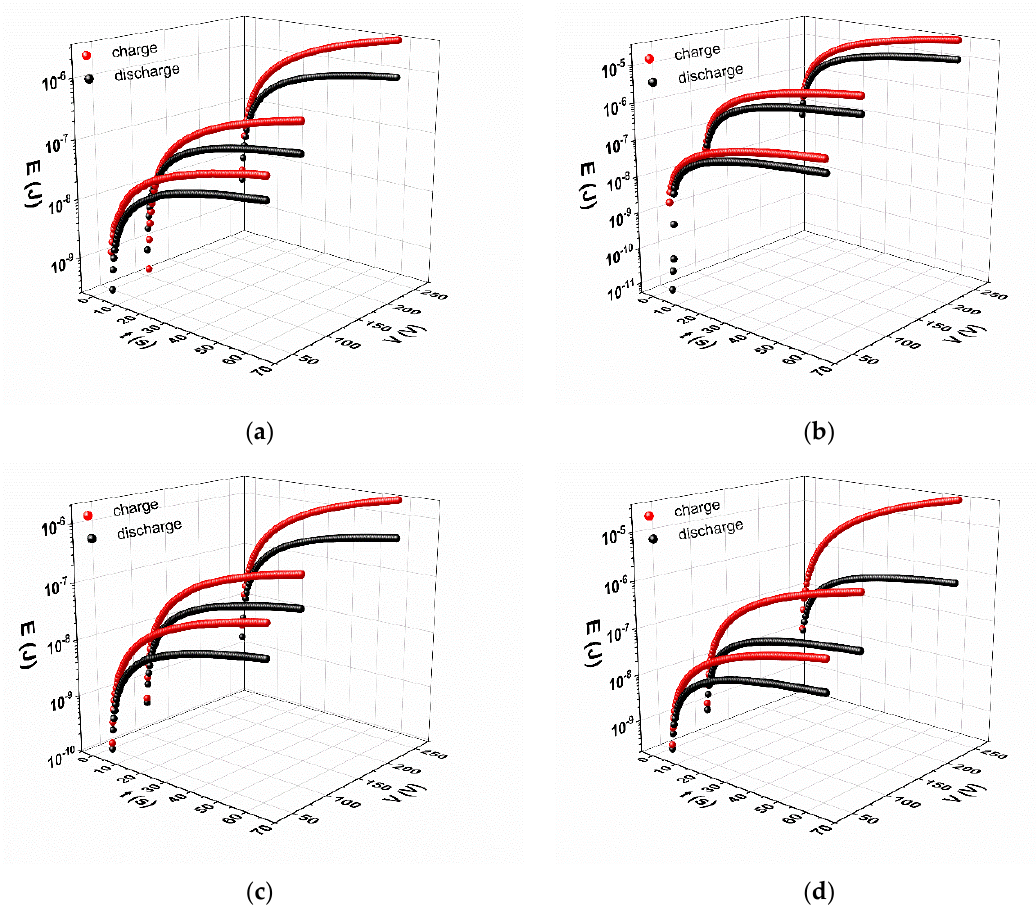
Figure 7. The stored and harvested (discharging procedure) energies as a function of time and voltages for the nanocomposites with 3 phr: ( a ) CB; ( b ) MWCNT; ( c ) GnP; ( d ) ND content.